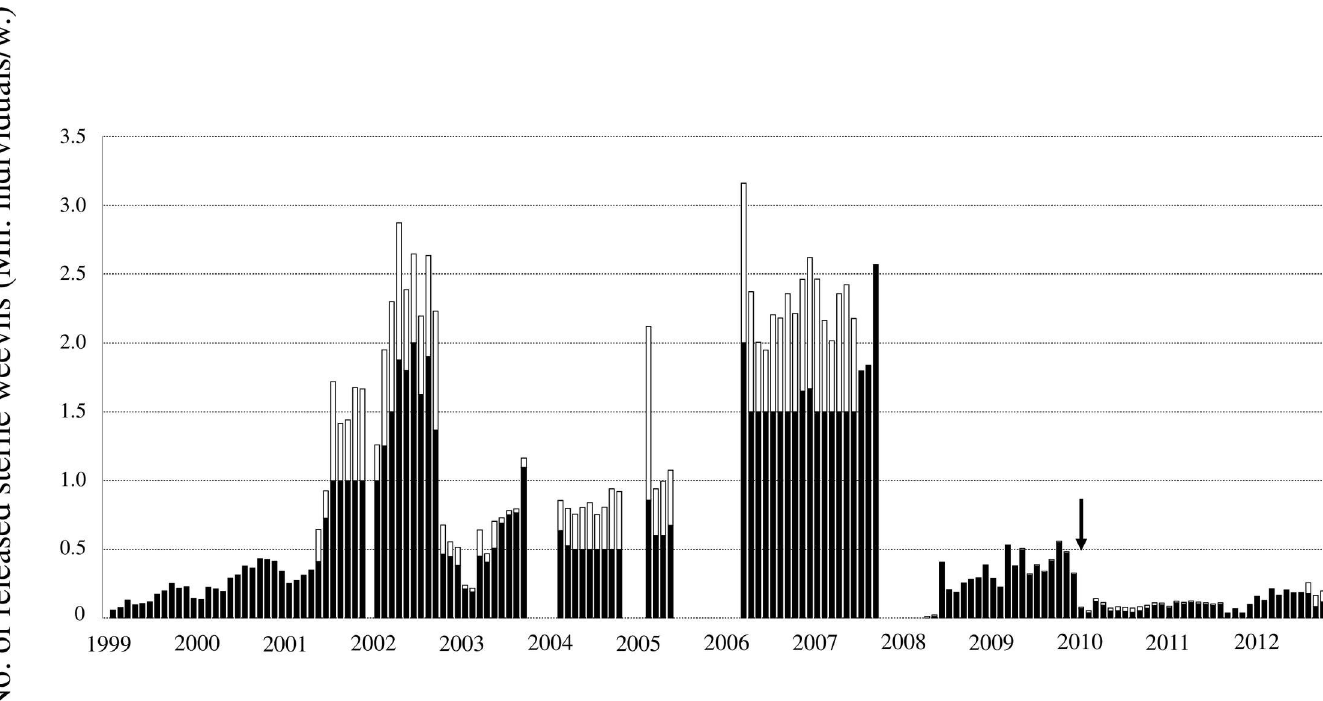
Fig 2. Number of sterile weevils C . formicarius released per week on Kume Island from 1999 to 2012. Black bars represent aerial releases and white bars represent ground releases. Short breaks in the release of sterile insects were implemented (January-February 2002, January-March 2004, January-March 2005, August 2005-March 2006, December 2007-March 2008) to allow for the detection of remaining areas of occurrence of C . formicarius using sex pheromone traps. The black arrow indicates the initiation of the release of the PE strain for SIT application in January 2010. Until July 2001, only males were released. However, thereafter, both sexes were released.